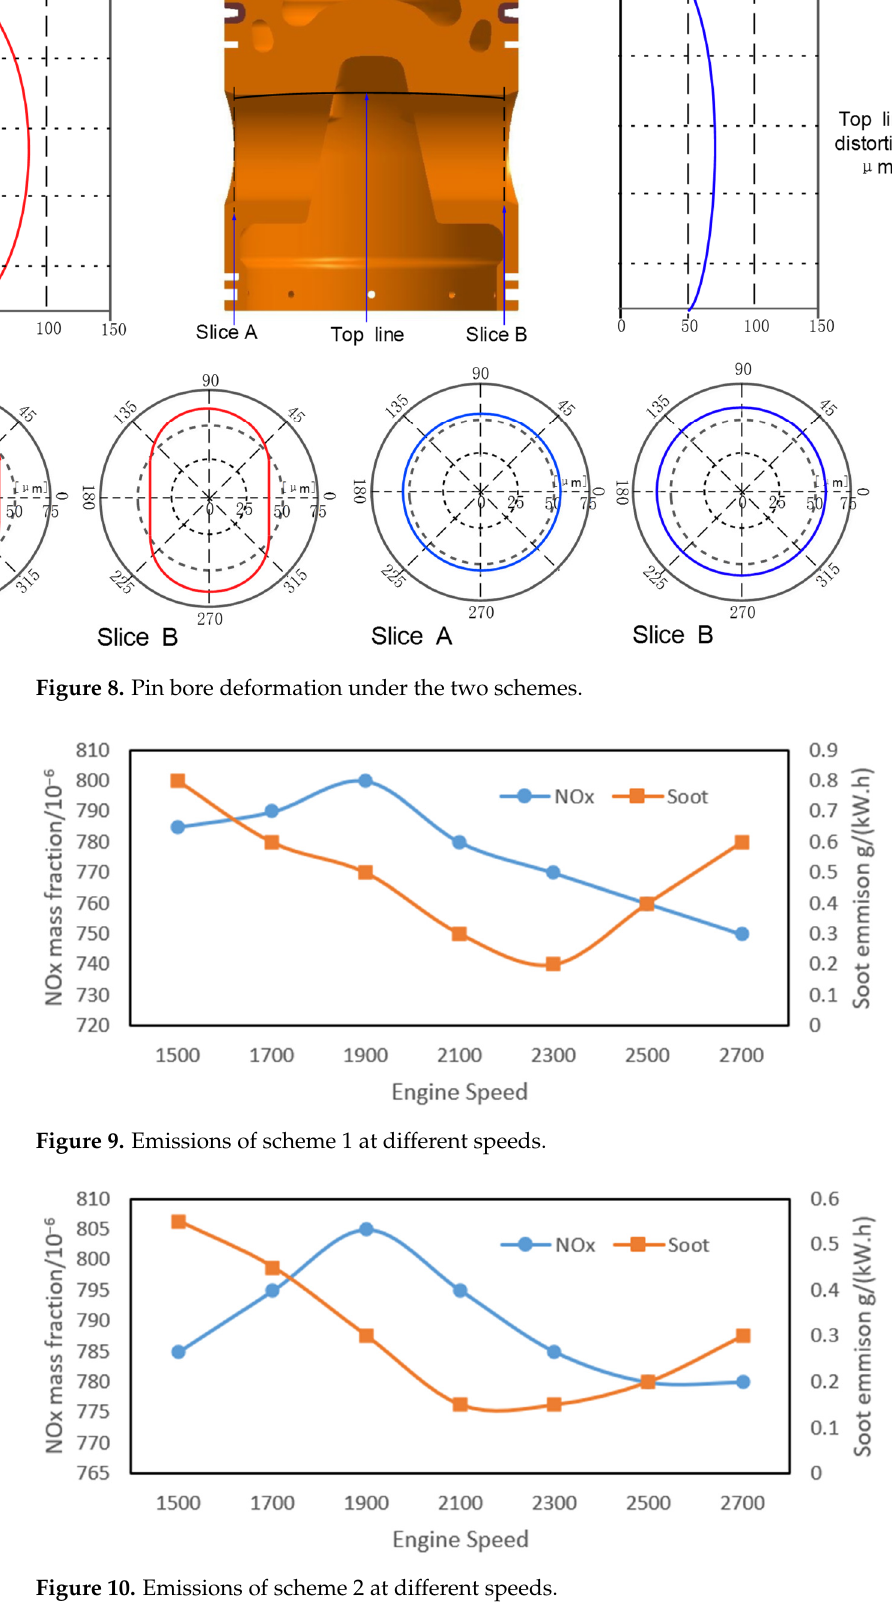
Figure 10. Emissions of scheme 2 at different